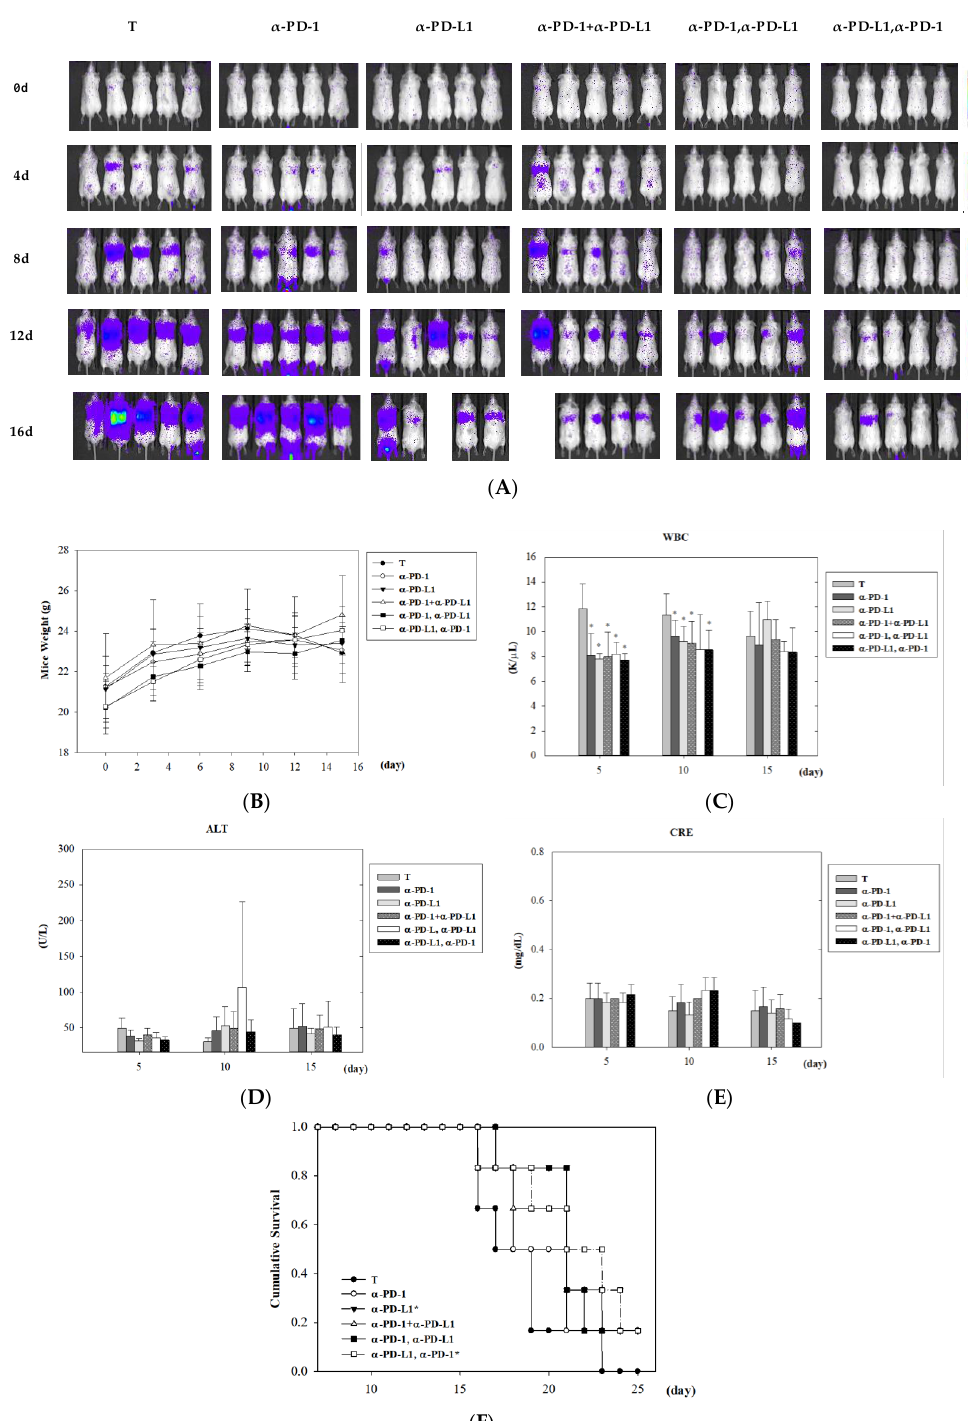
Figure 3. Therapeutic effects and toxicity in a lung metastatic animal model of monotherapy and various combination treatments of anti-PD-1 and anti-PD-L1. ( A ) Tumor growth of lung metastatic colon cancer-bearing mice after mono-, combined, and sequential treatment of PD-1 and PD-L1 antibodies. After seven days of intravenous cell injection (day 0), mice were treated with the indicated ICI therapies. Tumor growth of lung metastatic colon cancer was monitored using the IVIS imaging system at four-day intervals. General toxicities were examined by mouse weight ( B ), white blood cells ( C ), liver function with ALT ( D ), and renal function with CRE ( E ) within 15 days post-treatment. ( F ) Survival analysis was assessed in lung metastatic mice with visible tumor burden in the lung. In ICI-treated groups, statistical analysis was performed with the tumor (T) group (* p < 0.05). n = 6 for each group. ALT = alanine aminotransferase; CRE =